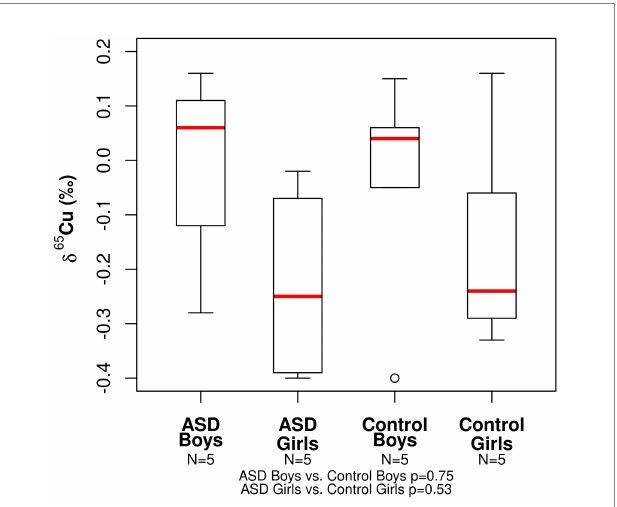
FIGURE 1 Boxplot for the Cu isotopic composition expressed as δ 65 Cu (‰) of bulk serum for the ASD and control populations.